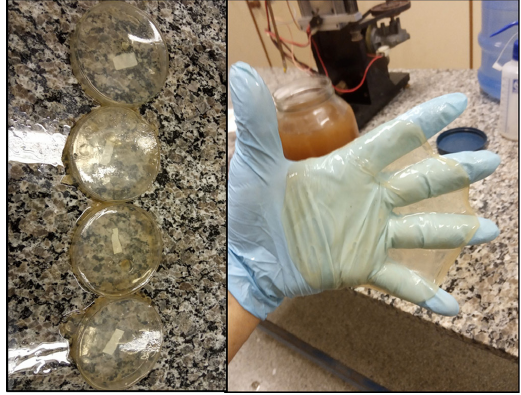
Figure 1. Characteristic of the films developed by the four different concentrations of Maytenus rigida